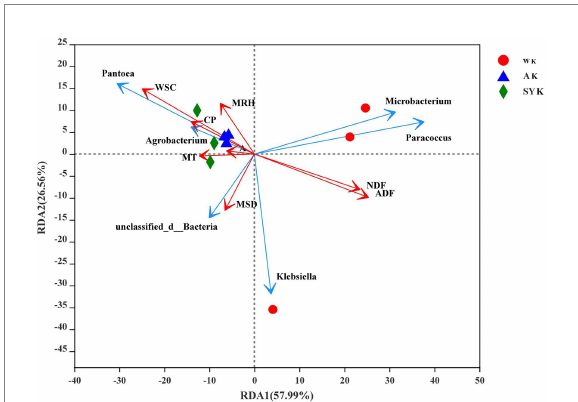
FIGURE 1 Redundancy analysis the relationship between environmental factors and nutrient composition, microbial community structure of raw materials. The axes are labeled with the percentage of total variance explained (%). Red arrow lengths indicate the variance explained by environmental factors and nutrient composition, and the blue arrow lengths indicate the variance explained with the microbial community structure. Different graphics represent raw material samples of three regions. MT, mean temperature; A, altitude; MRH, mean relative humidity; MSD, mean sunshine duration; CP, crude protein; WSC, water- soluble carbohydrate; NDF, neutral detergent fiber; ADF, acid detergent fiber; WK, China, Inner Mongolia, Ordos-wushenqi; AK, China, Inner Mongolia, Hohhot; SYK, China, Inner Mongolia, Ulanqab-siziwangqi.